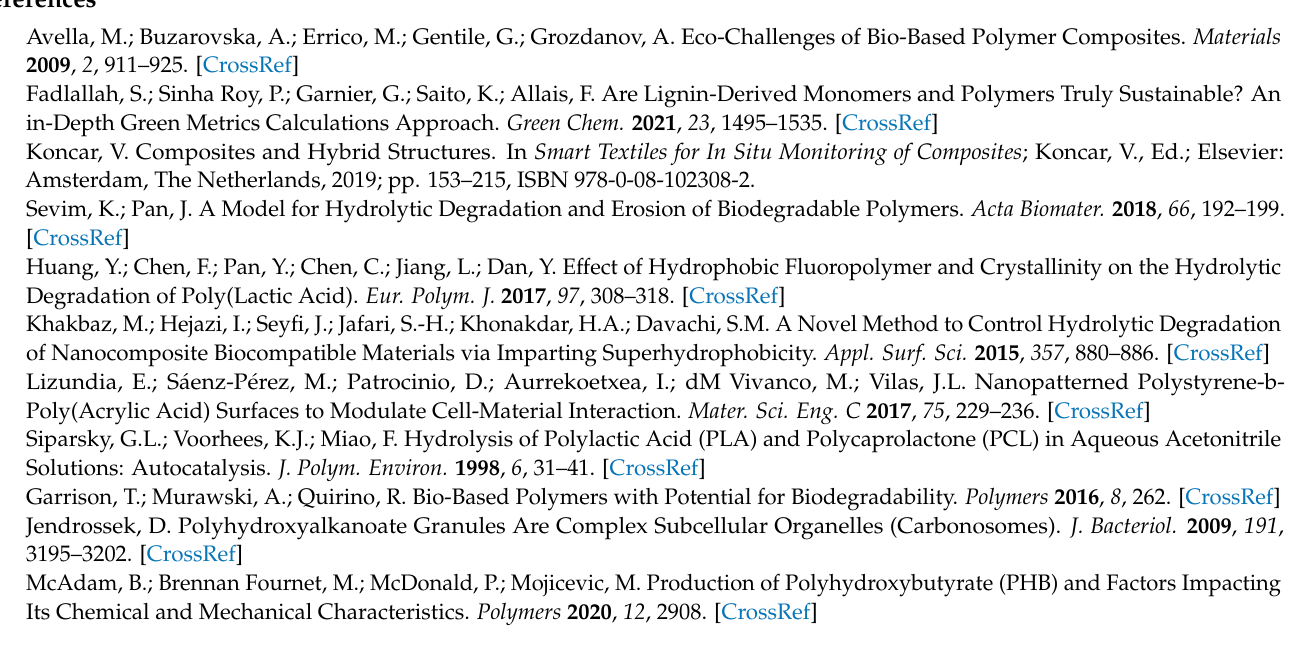
Figure S3: 1 H- 1 H COSY (CDCl 3 ) of PHB/BDF (40 w%) after 32 h of degradation with NaOH solution (0.25 M); Figure S4: 1 H NMR (CDCl 3 ) spectra of powders of PHB blends after 7 days of reaction with 5.8 mg · mL − 1 of Lipopan © 50 BG at pH = 7.4, 37 ◦ C and stirred at 50 rpm; Figure S5: Pictures of the PHB film a./ at t0 and b./ after 4 weeks in the soil samples c./ microscopic observation of A. elegans , the aseptate hyphae and sporangia are